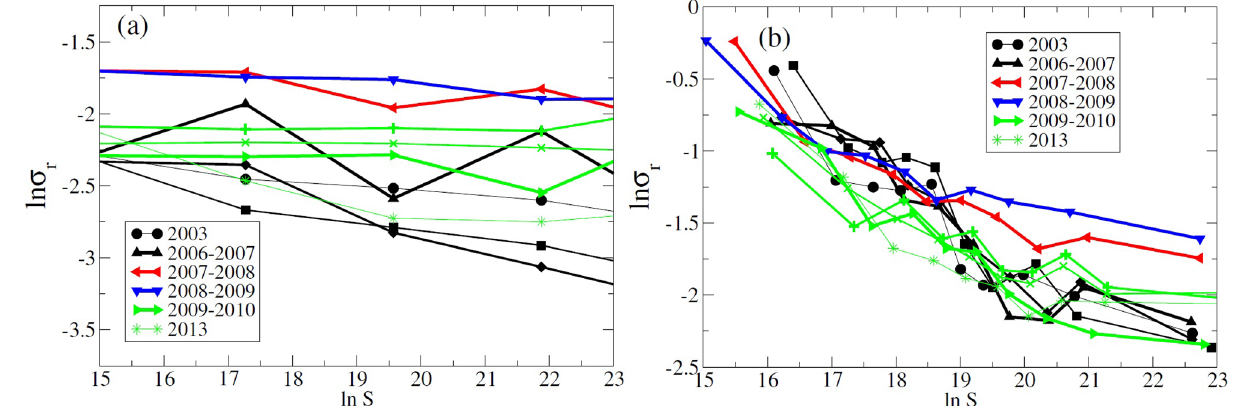
Figure 2. Size-variance relationship for modified data analysis. Log–log plot ( a ) shows the size-variance relationship assuming that market values of stocks vary only due to price changes while the corresponding quantity held in the portfolio is maintained from time t − 1 to t . Log–log plot ( b ) reports the size-variance relationship when all growth events are excluded if at the beginning or at the end of any time quarter, the percentage of stocks in the corresponding fund does not belong to the interval from 98 to 102%.